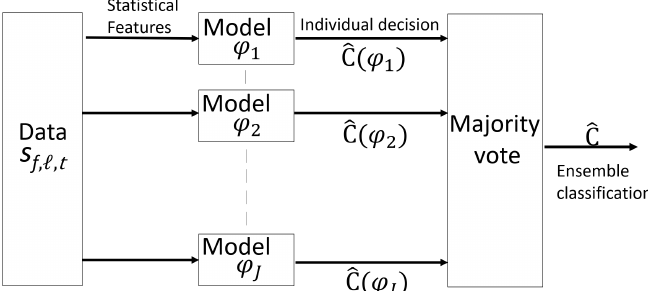
Figure 7. Block diagram of the ensemble classifier where the input data are the CSI samples. Multiple features, that are used as input to the model blocks, include mean µ , standard deviation σ , skewness ζ , and kurtosis κ computed in the frequency { µ (cid:96) , σ (cid:96) , ζ (cid:96) , κ (cid:96) } (6) and space { µ LSTM and FF-NN models are used in model blocks ϕ j and an individual decision is made by each block. Ensemble classification ˆ C is based on majority vote of individual decisions ˆ C ( ϕ j )